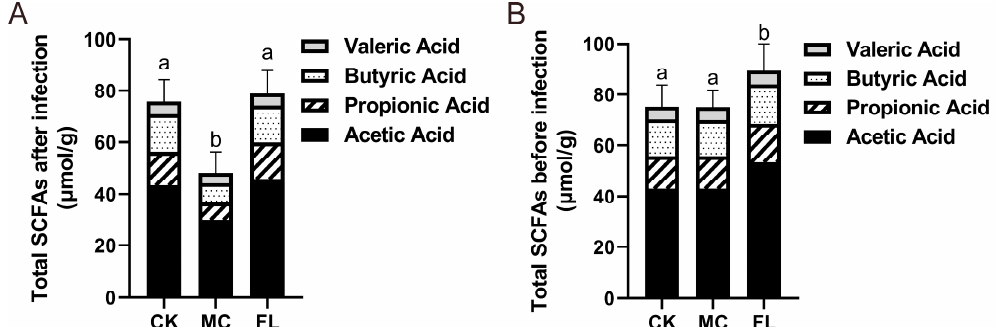
Figure 5. Total amount of short-chain fatty acids (SCFAs) in feces before and after infection. ( A ) Before infection; ( B ) after infection. Levels of di ff erent types of SCFAs are reflected. Di ff erent letters (a, b) are infection; ( B ) after infection. Levels of different types of SCFAs are reflected. Different letters (a, b) are used to express significant di ff erences between total SCFAs ( p < used to express significant differences between total SCFAs ( p < 0.05).